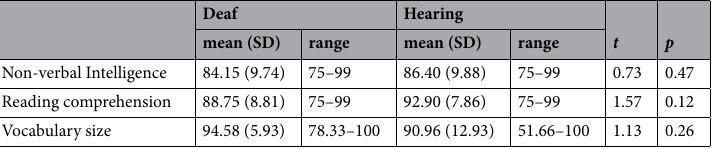
Table 2. Characteristics of the experimental and control groups. Non-verbal intelligence was measured with the Raven Progressive Matrices test 69 , where participants had to identify the missing item of a sequence of figures. Spanish reading comprehension was assessed through the ECL-2 64 , a standardized reading test consisting of five short paragraphs followed by a total of 27 multiple-choice questions evaluating word meaning, synonyms, antonyms, sentence and text content. Vocabulary size was measured using the Spanish version of the LexTALE 70,71 , a lexical decision test consisting of 60 real words and 30 nonwords providing a good estimate of language knowledge 72 . All scores are percentages. Results of two-tailed t -tests are reported for each group